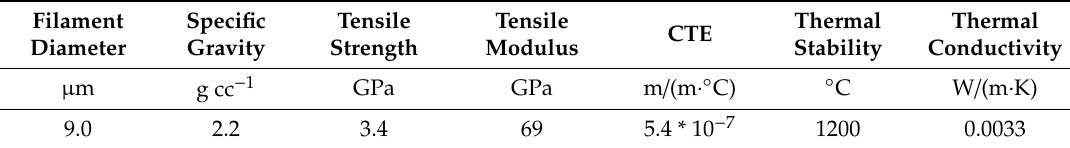
Table 1. The material properties of silica glass fibers in quartz woven